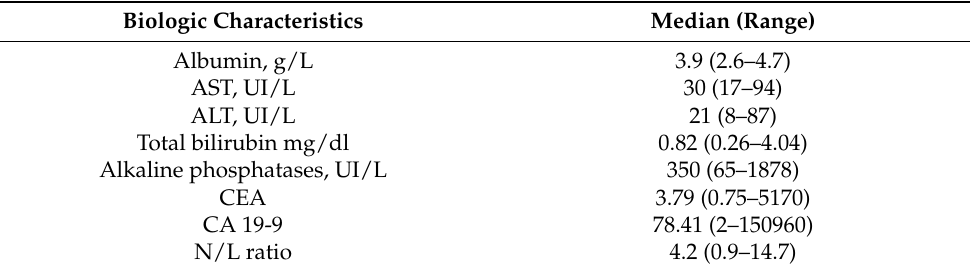
Table 2. Biologic characteristics at baseline.